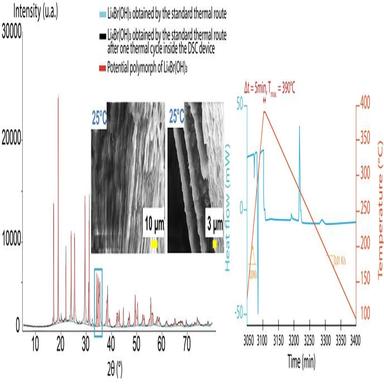
XRD diffractogram with the related morphology of the potential Li4Br(OH)3 polymorph obtained with the Alfa Aesar educts. On the right, its related DSC signal.